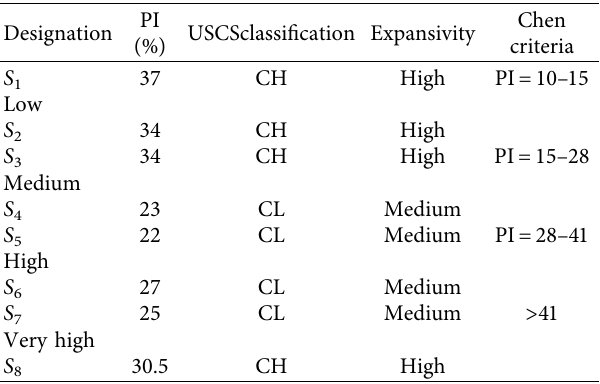
Figure 3: Position of the investigated soil on Casagrande plasticity chart. Table 2: Classification of the investigated soil concerning USCS and Chen criteria